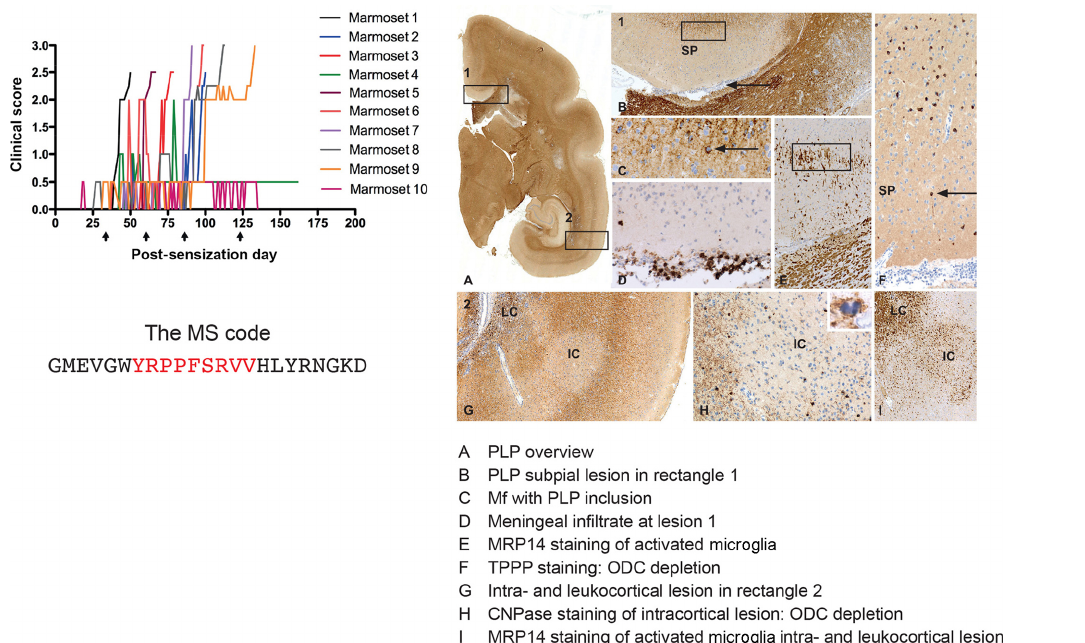
Figure 9. Clinical and pathological aspects of an atypical EAE model induced with MOG34-56/IFA . Immunization with MOG34-56/IFA at a 28d interval (arrows) induces 100% clinical EAE with a variable time of onset. Notice that the only information relayed to the marmoset’s immune system is the sequence of 23 letters (CTL core epitope in red). Immunostaining for PLP shows lesions in the white and grey matter (A). Rectangle 1 indicates a demyelinated region in the cingulate cortex, which is characterized by complete demyelination (B), presence at the lesion edge of macrophages containing a PLP + inclusion particle (C), activated MRP14 + microglia (E) and depletion of oligodendrocytes (F). Immune cells (CD3) were only detected in meninges. Rectangle 2 (A) indicates a leukocortical and an intracortical lesion (G), which are also depleted from oligodendrocytes (H) and contain abundant MRP14 + microglia. Mf is macrophage, TPPP is tubulin polymerization-promoting protein, ODC is